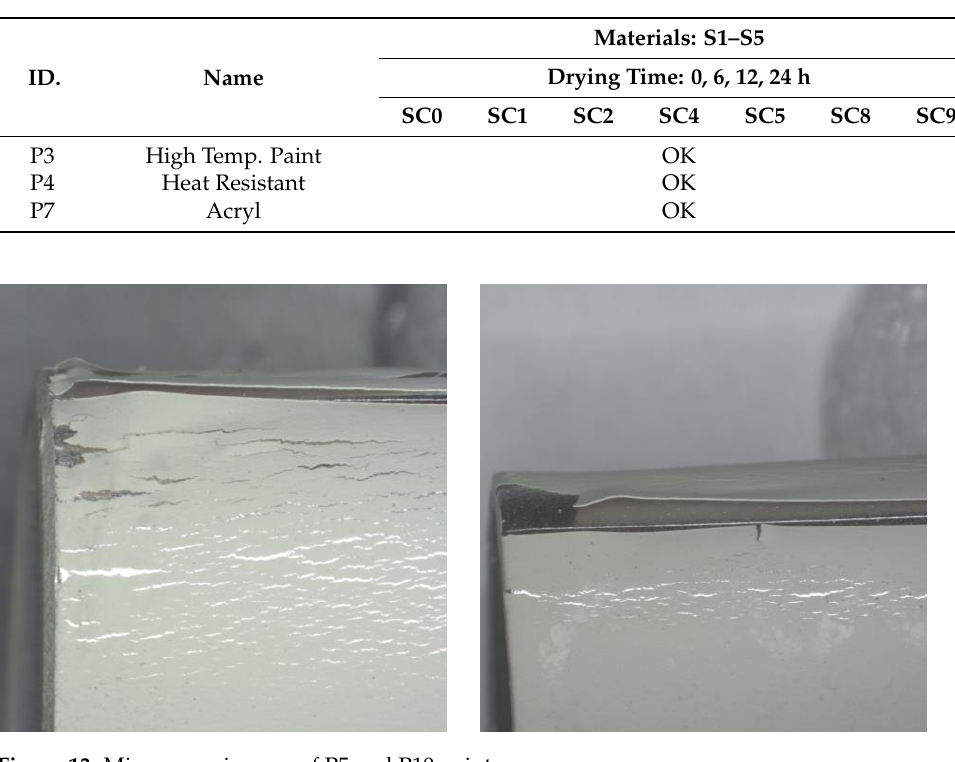
Table 10. Results of the visual inspection of the Erichsen test.